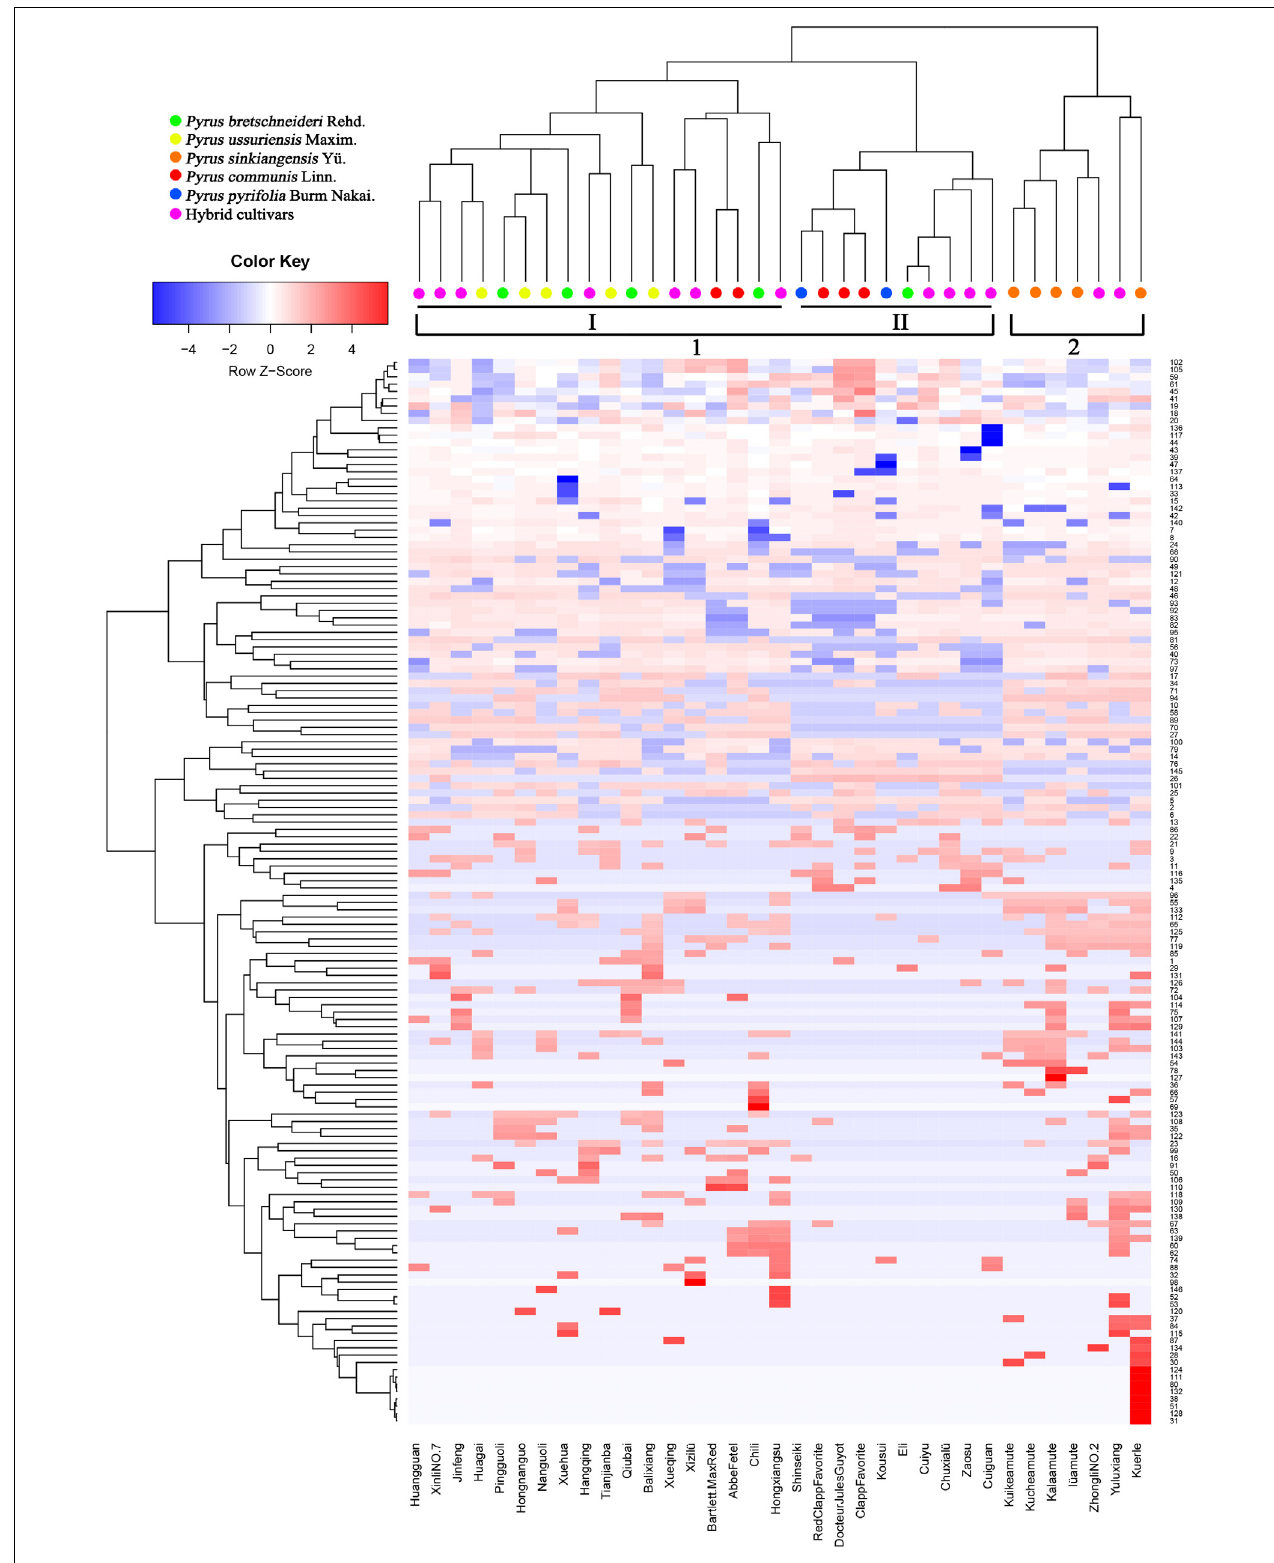
FIGURE 4 | Heatmap and clustering of 146 wax components in 35 pear cultivars. Colors indicate chemical composition levels. The numbers of each row represent the wax component numbers corresponding to the accession numbers in Supplementary Table S1. Each column represents a pear cultivar.